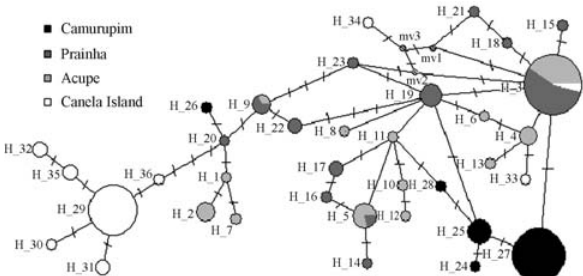
Figure 3 - Median joining haplotype network. Each trace corresponds to a single mutation. The haplotypes are represented by circles, the width be- ing proportional to their frequencies; mv1, mv2 and mv3 are median vec-